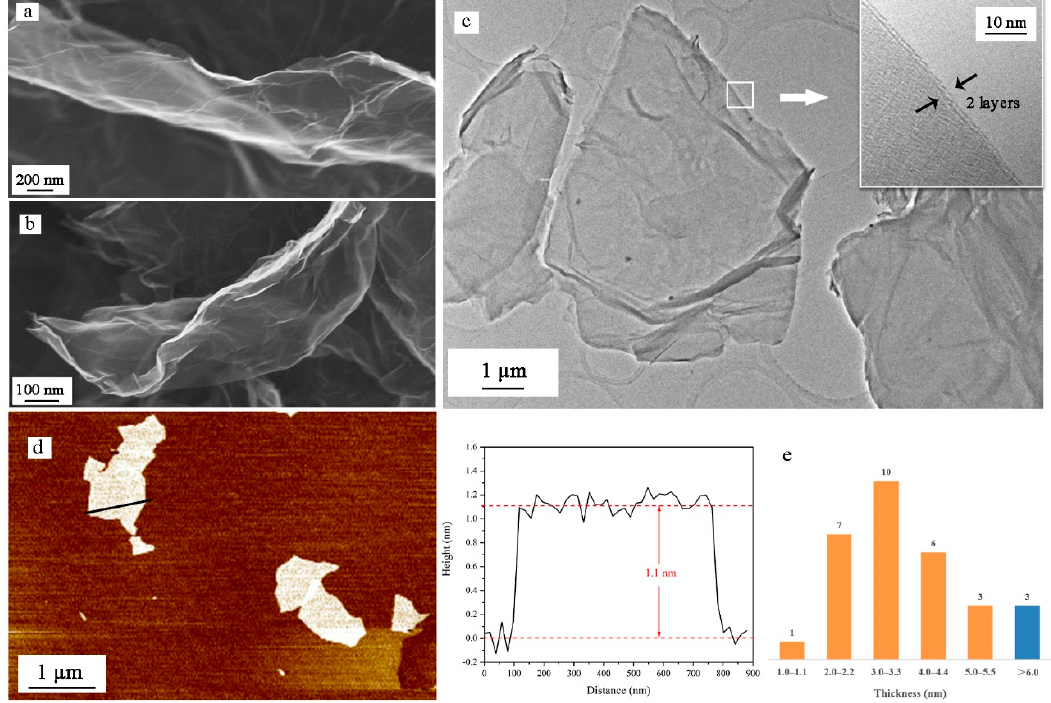
Figure 4. ( a ) Scanning electron microscopy (SEM) images of GO sheet; ( b ) SEM images of NGO sheet; ( c ) transmission electron microscopy (TEM) images of NGO sheet and high-resolution imagine of the edges of NGO; ( d ) atomic force microscopy (AFM) images of NGO sheet and the height distribution along the path; ( e ) thickness distribution of 30 NGO samples.